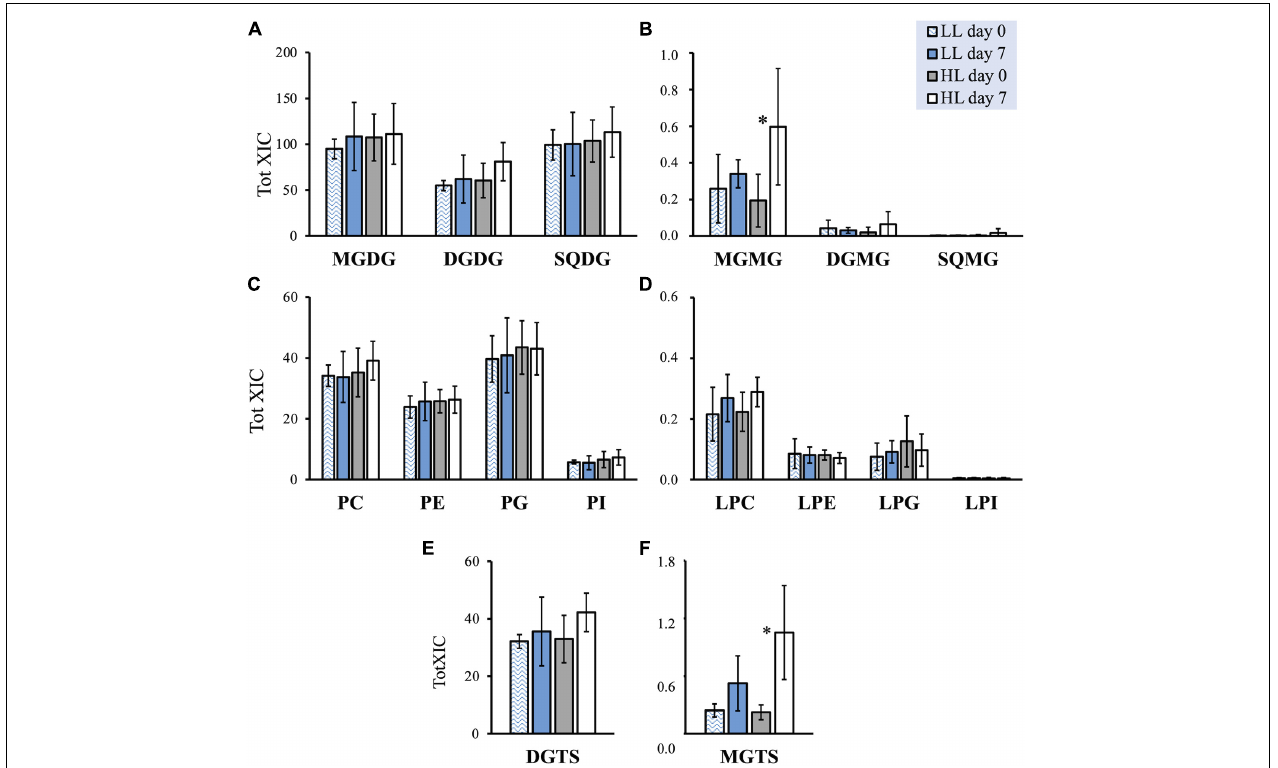
FIGURE 4 | Sum of the normalized extracted ion chromatograms (XIC) areas (mean ± SD; n = 5) of the peaks identified for the lipids species of glycolipid, phospholipid, and betaine lipid classes in Codium tomentosum exposed to low light (LL) and high light (HL), at the beginning (day 0) and at the end (day 7) of the light acclimation. (A) Glycolipids (MGDG, DGDG, SQDG); (B) Lyso-forms of glycolipids (MGMG, DGMG, SQMG); (C) Phospholipids (PC, PE, PG, PI); (D) Lyso-forms of phospolipids (LPC, LPE, LPG, LPI); (E) Betaine lipids (DGTS); (F) Lyso-forms of betaine lipids (MGTS). Asterisks indicate significant differences between day 0 and day 7, within the same light condition ( t -test): ∗ p <